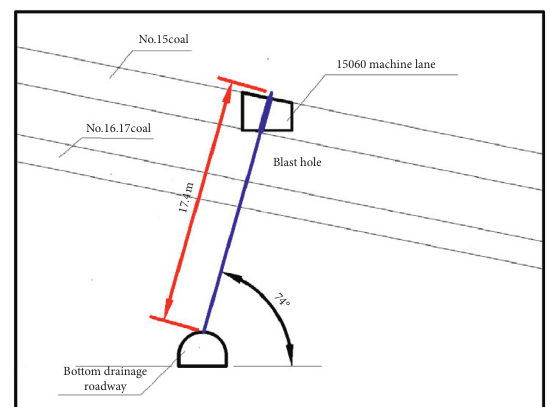
Figure 5: Sectional view of pressure blast hole.